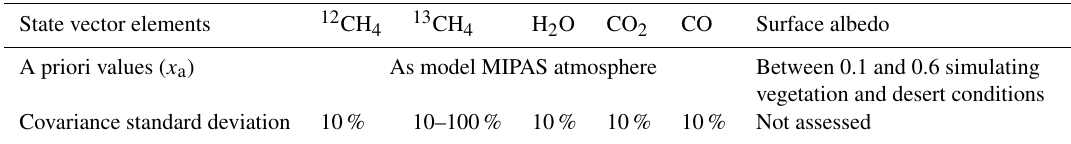
Table 2. Parameters for information content analysis.